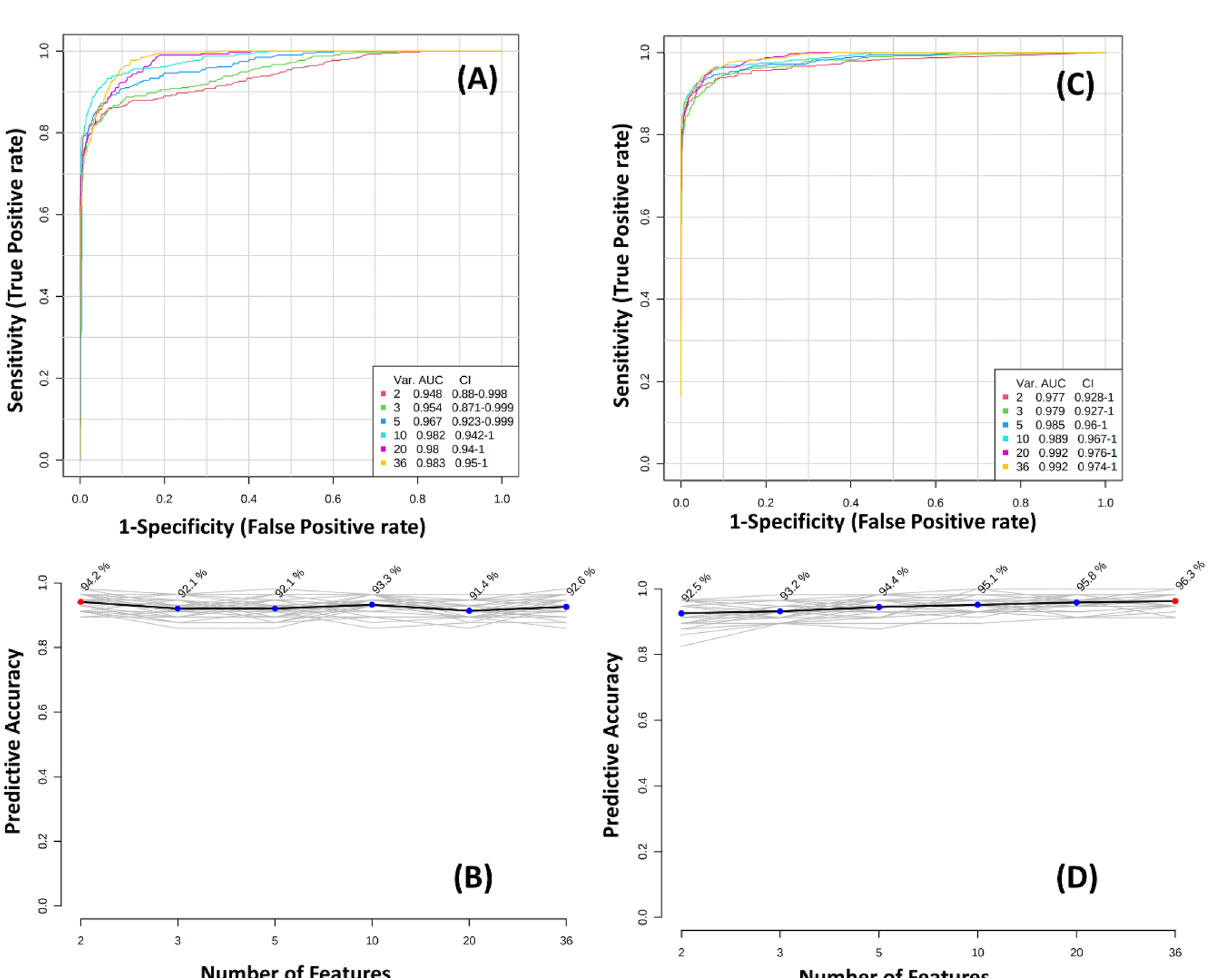
Figure 9. Receiver Operating characteristics (ROC) curve analysis and Predictive accuracies of different features of ( A , B ) PLS-DA and ( C , D ) Random